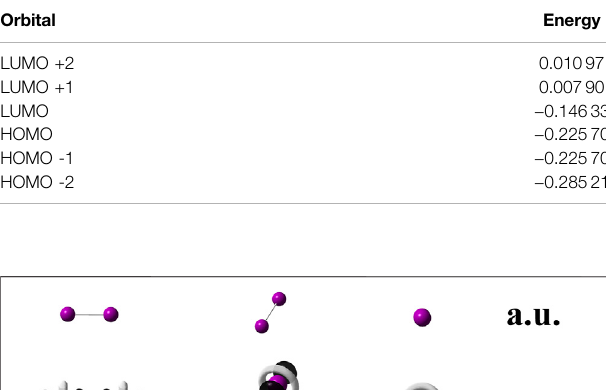
TABLE2| Energies(inHartree)ofmolecularorbitalsinthediiodinemoleculeatthe M06 – L/def2 – QZVPPD level of theory.